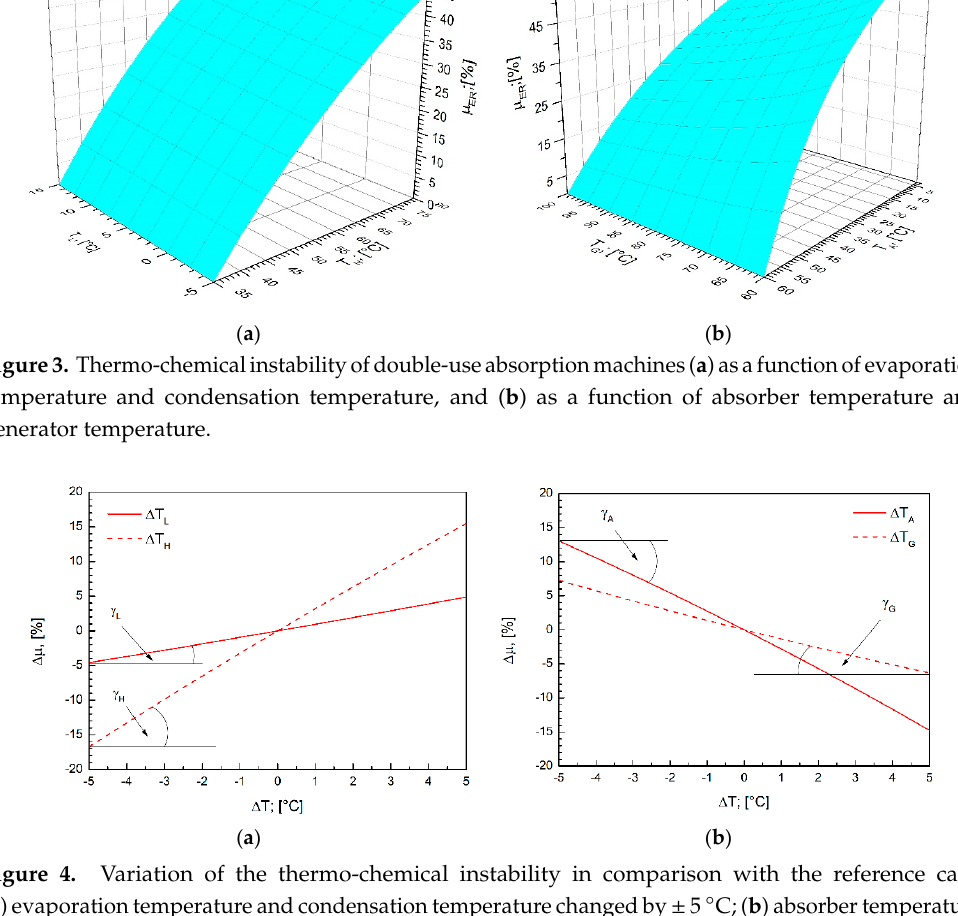
Figure 4. Variation of the thermo-chemical instability in comparison with the reference case: ( a ) evaporation temperature and condensation temperature changed by ± 5 °C; ( b ) absorber temperature and generator temperature changed by ± 5 °C.